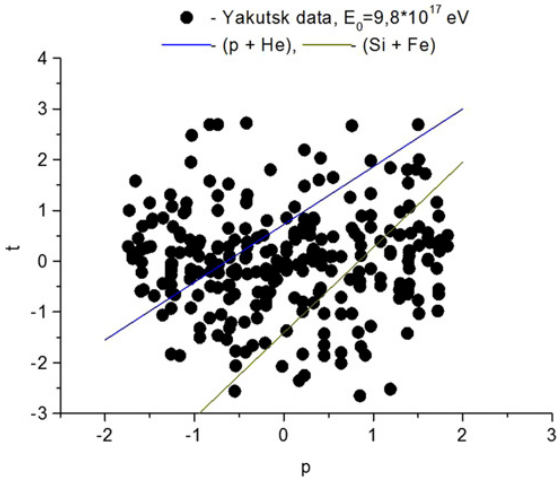
Figure 2. Standardized experimental data for X max and ρ e (600) at different energies. Line m1 – divides nuclei (P + He) and C, line m2 – divides C and (Si +